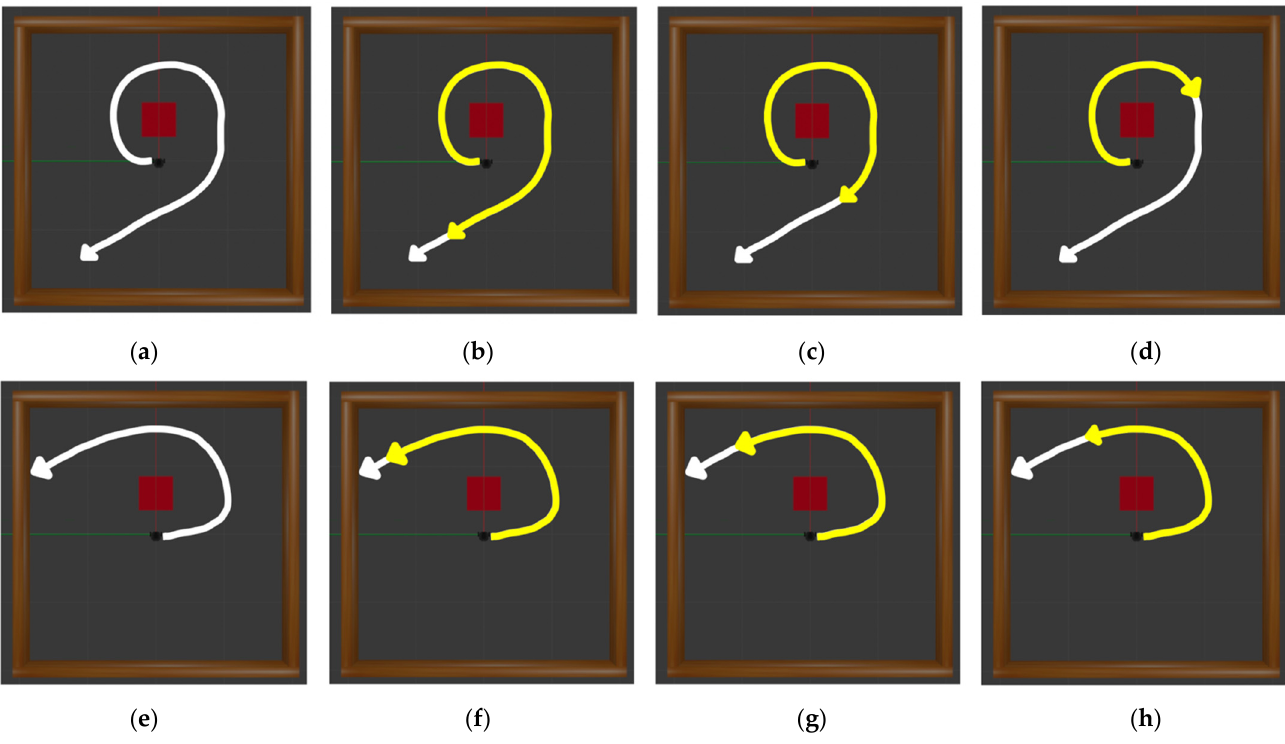
Figure 6. White lines are the trajectories of failed episodes and yellow lines are the sub trajectories generated from these white lines. ( a ) Case of the maximum-step trajectory, and the ( b – d ) trajectory generated according to each step of 50, 150, and 250. ( e ) Case of the collision trajectory, and the ( f – h ) trajectory generated according to each step of 5, 25, and 50. While the previous reinforcement learning algorithms without HER stores only ( a , e ) in the replay buffer, the proposed method appends ( b – d , f – h ) as well as ( a , e ), to the replay Algorithm 1: Hindsight Experience Replay